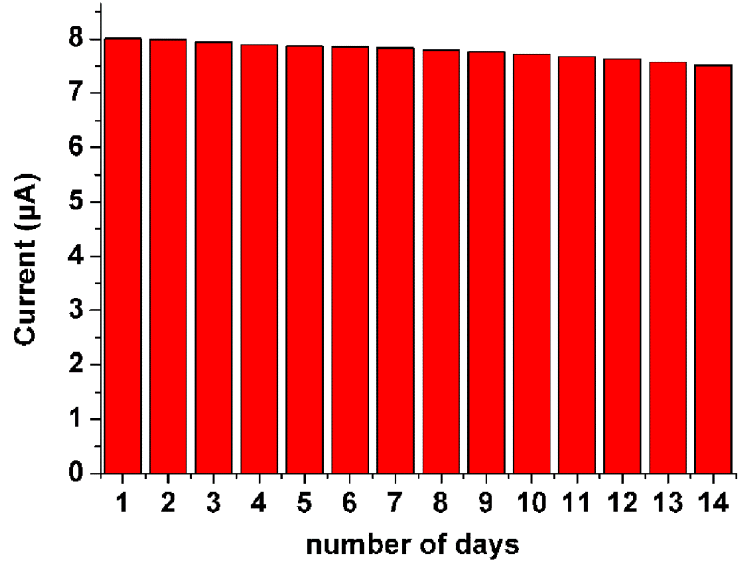
Figure 5. Determination of reproducibility of developed GOx/N-doped CDs/chitosan modified GCE in air-saturated PBS containing 10% of serum sample with: ( a ) 1 mM and ( b ) 5 mM glucose.